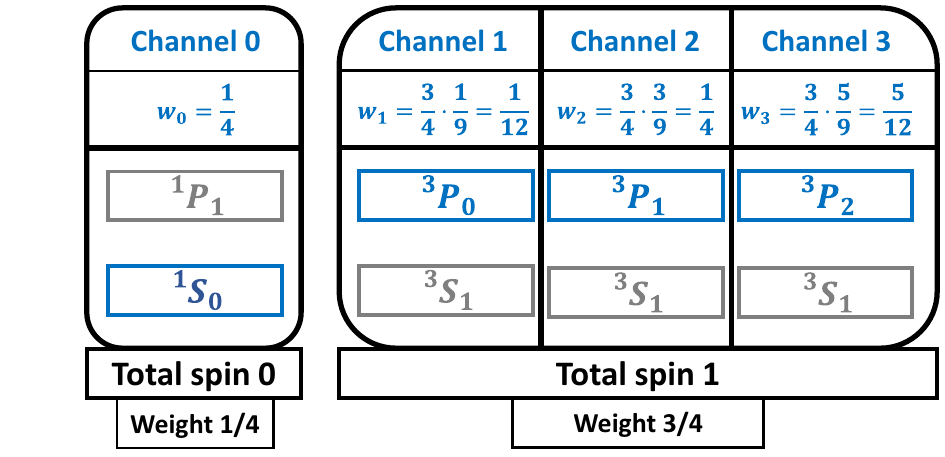
Fig. 13 An example for the CATS input when both the s- and p-wave interactions are included. There are four distinct interaction channels: ψ = ψ + ψ + ... , 0 1 S 0 1 P 1 ψ = ψ + ψ + ... , 1 3 S 1 3 P 0 ψ = ψ + ψ + ... and 2 3 S 1 3 P 1 ψ beyond the p -wave, which are assumed to have no influence on C ( k ) and are thus considered irrelevant. The grayed out states are not allowed in the case of p–p correlation, but can be included if needed, e.g. for p–